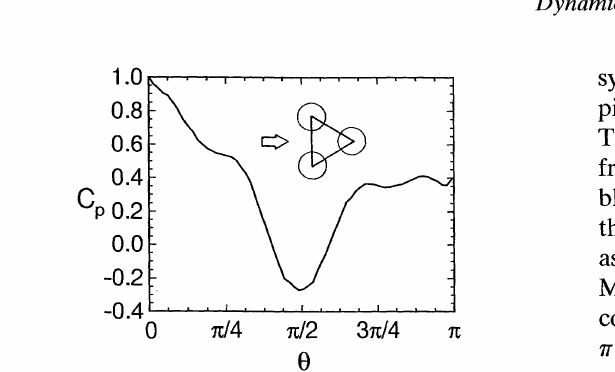
FIGURE 6 Distribution of pressure coefficient with tube angles for a staggered tube bundle.